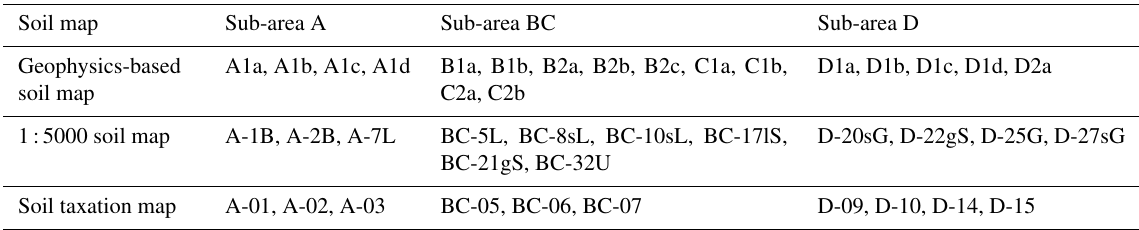
Figure 2. (a) Geophysics-based soil map of the study area with examples of the quantitative description of the soil characteristics (soil units A1a and C1a are shown); (b) 1:5000 soil map of the study area with examples of the qualitative description of the soil characteristics (soil units A-1B and A-7L are shown) (Röhrig, 1996); and (c) soil taxation map of the study area and examples of the qualitative description of the soil characteristics (unit A-01 is shown) (NRW, 1960). The spatial distribution of all soil units within the study area and their codes are shown in Fig. 3. Table 2. Unified codes of the soil units for the three soil